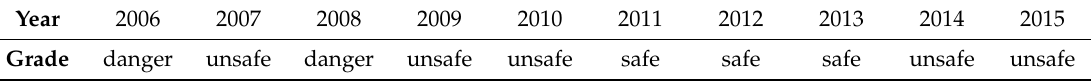
Table 7. Comprehensive rare earth resource evaluation security level from